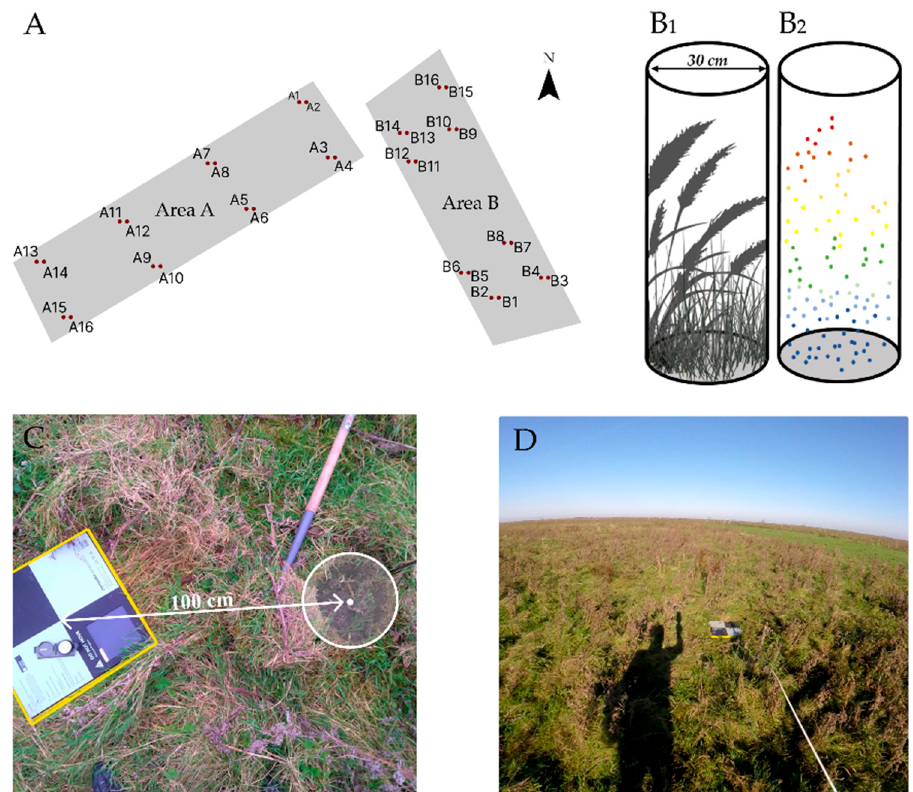
Figure 4. ( A ) Locations of the thirty-two grassland samples in areas A and B. The cylinder in ( B1 ) depicts a field-based AGB situation, and ( B2 ) depicts the corresponding LiDAR point cloud. ( C ) Example of circular vegetation sampling 100 cm west of an AeroPoint TM . ( D ) Video recording example during scan trajectory.